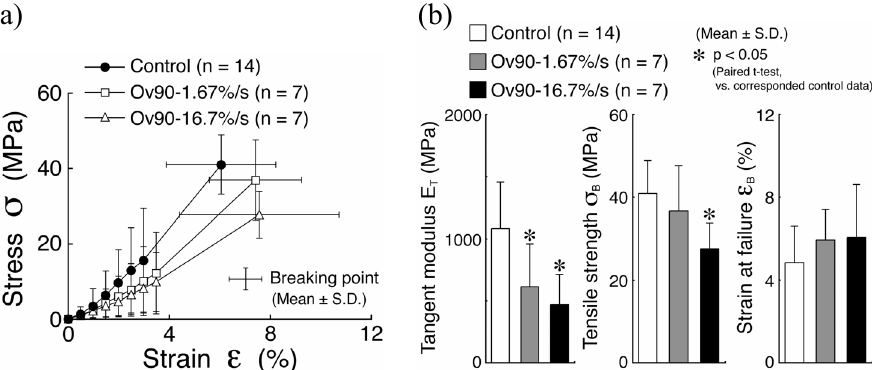
Fig. 4 Stress-strain curves (a) and tensile properties (b) of the control specimens and the specimens overloaded to 90% of the failure stress of the normal tendons at the strain rate of 1.67 (Ov90-1.67%/s group) and 16.7 %/sec (Ov90-16.7%/s